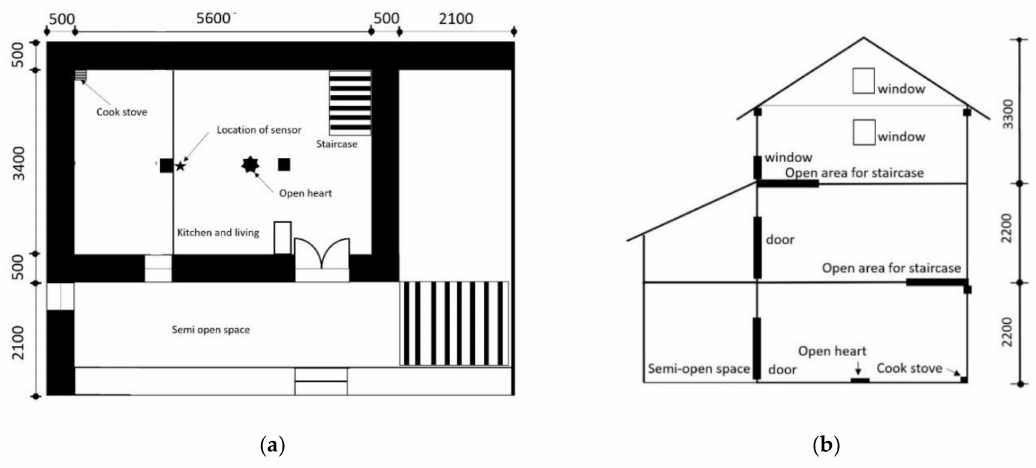
Figure 3. Design of a typical house in investigated area: ( a ) Plan view and ( b ) Sectional view (unit: mm).